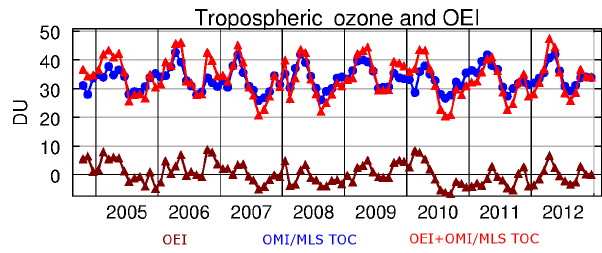
Figure 14. Time series of tropospheric ozone columns “corrected” with OEI over AS (10–20 ◦ N, 60–70 ◦ E) from 2004 to 2012. The blue curve represents OMI/MLS TOCs, dark red is OEI calculated from OMI/MLS and red stands for OMI/MLS TOCs with OEI “cor-